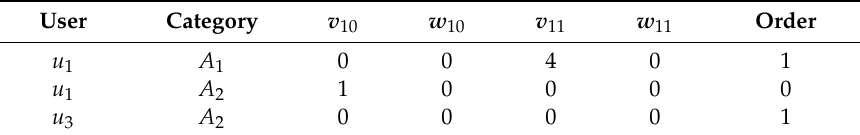
Table 3. Preparation of training data from user log in Table